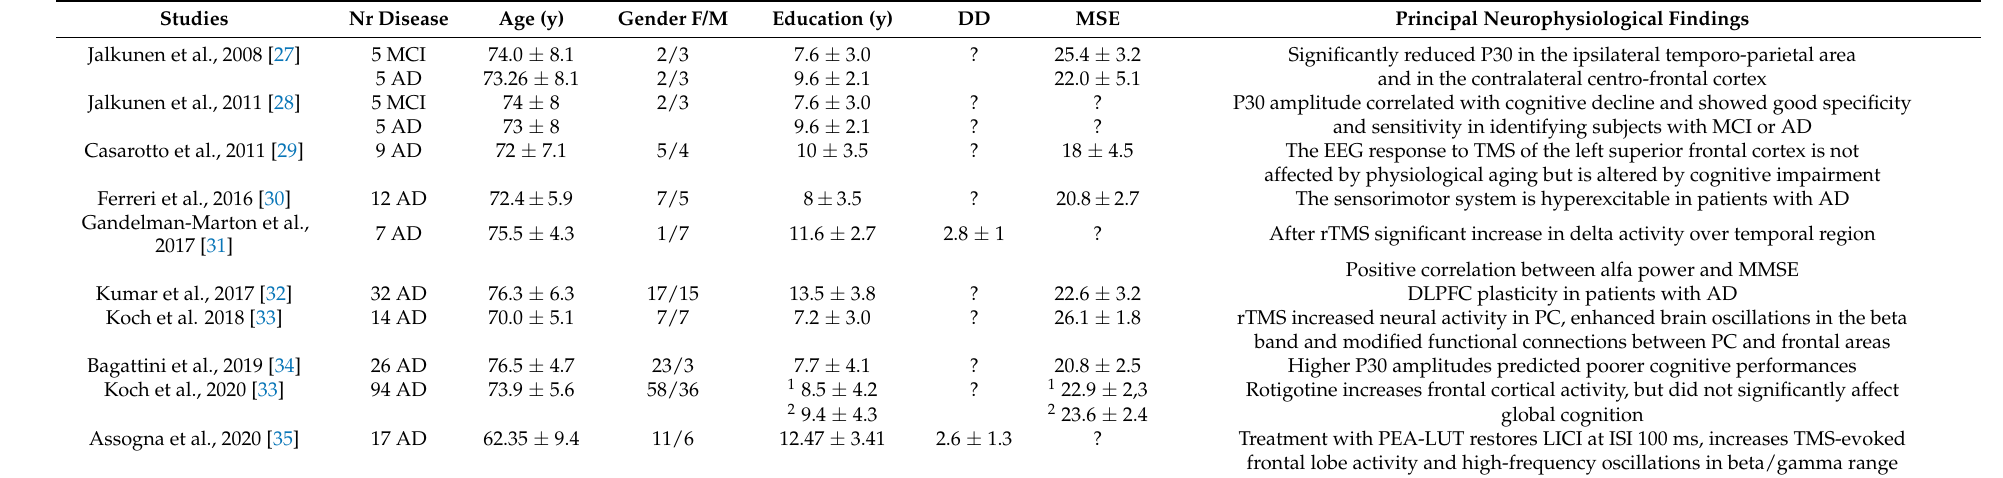
Table 1. Demographic characteristics of the patients and principal findings of the